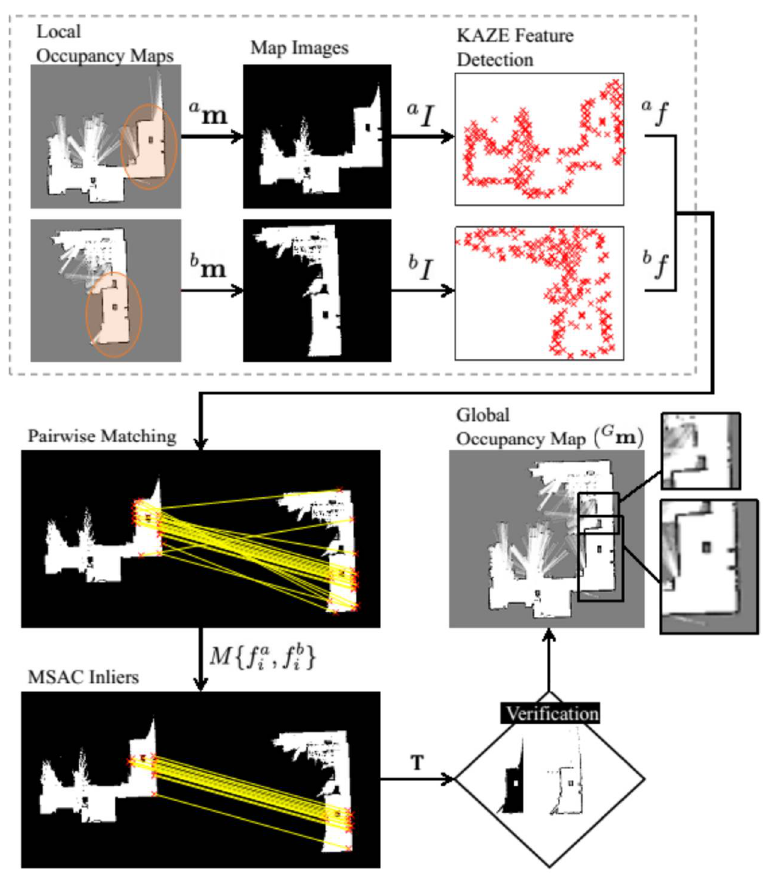
Figure 11. Feature matching technique using two maps with same grid resolutions ( r a = r b = 20 cells/m).